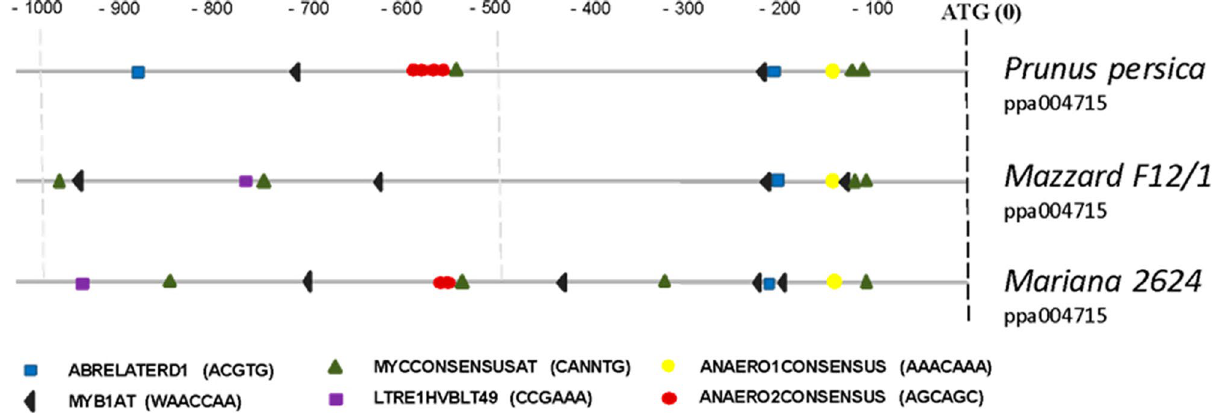
Figure 1. Representation of putative regulatory elements in Prunus HXK3 promoters. In silico analysis was performed using the PLACE (http:// www. dna. affrc. go. jp/ PLACE) and PlantCARE databases (http:// bioin forma tics. psb. ugent. be/ webto ols/ plant care/